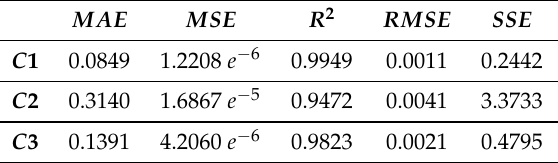
Table 2. Goodness-of-fit statistical